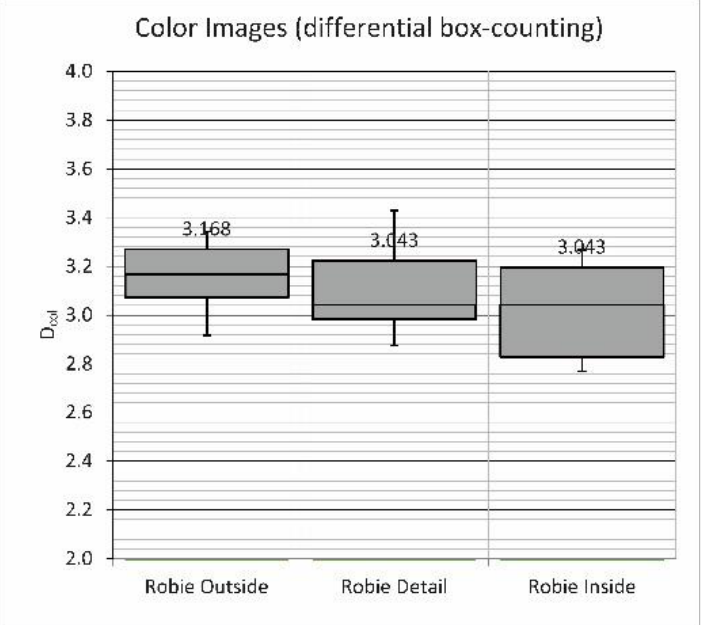
Figure 18. Box plot with median of the differential box-counting method of 23 exterior images, 17 detail images and 31 interior images of Robie House.